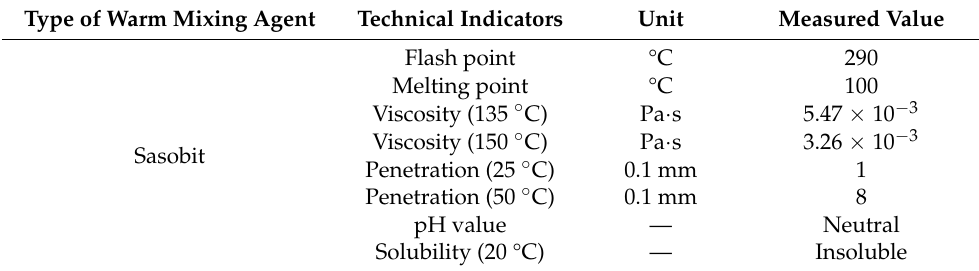
Table 2. Main technical parameters of warm mix additives.